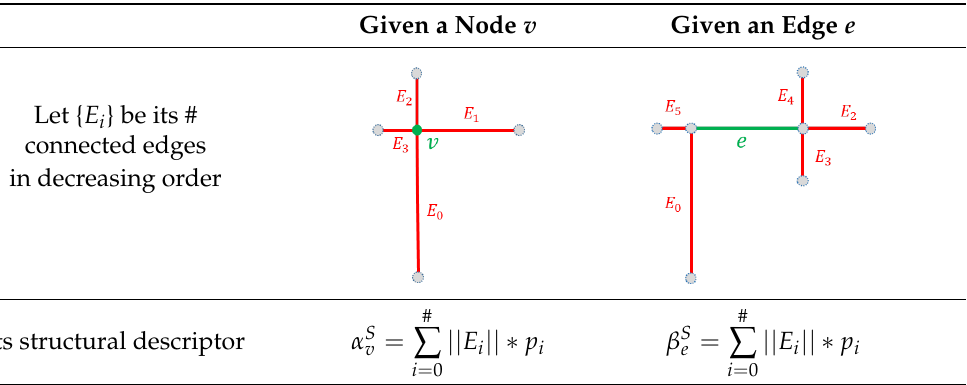
Table 1. Structural descriptor computation for a node v and an edge e according to their neighborhood in the